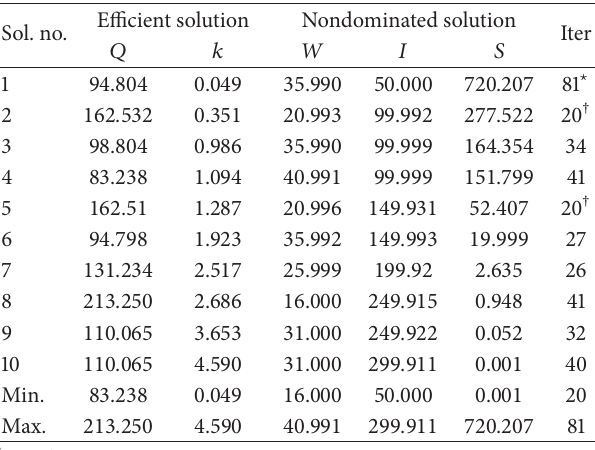
Table 2: Tradeoff solutions of Item 1 generated by successive approximation.